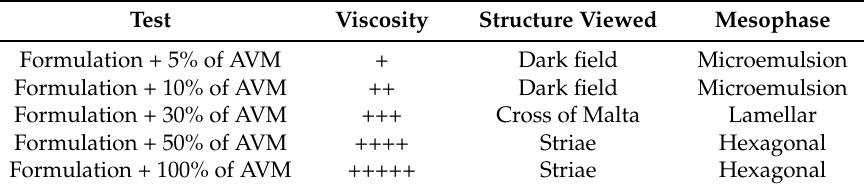
Table 1. Results of the evaluation of precursor behavior the formulation of liquid crystals by Polarized Light Microscopy (PLM).